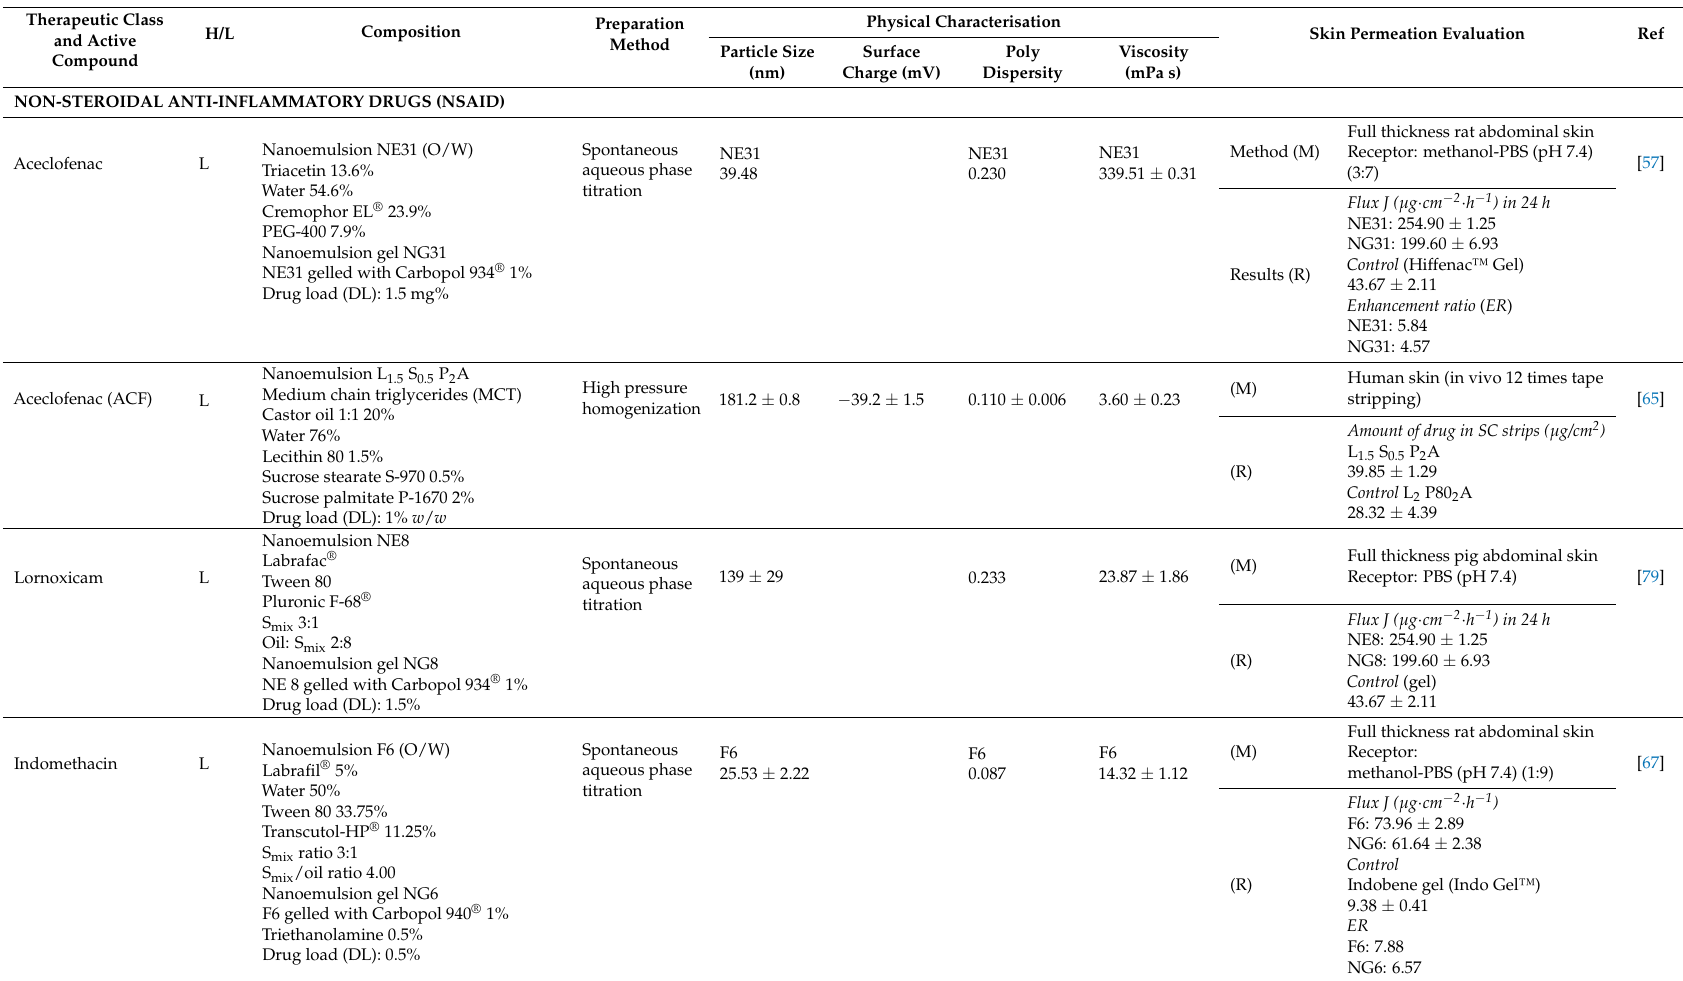
Table 2. Examples of nanoemulsion (NE) formulations evaluated for topical and transdermal delivery: hydrophilic (H) and lipophilic (L) nature of active compound, composition (detail where available), preparation method and physical characterisation of emulsion formulation, and skin permeation experimental details and